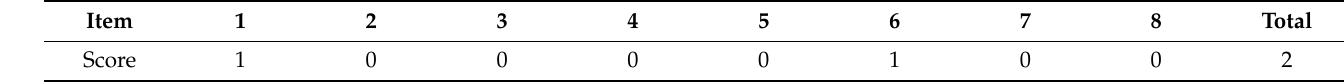
Table 1. Anna’s scores on the eight items of the subcomponent of Criminal History (CH).